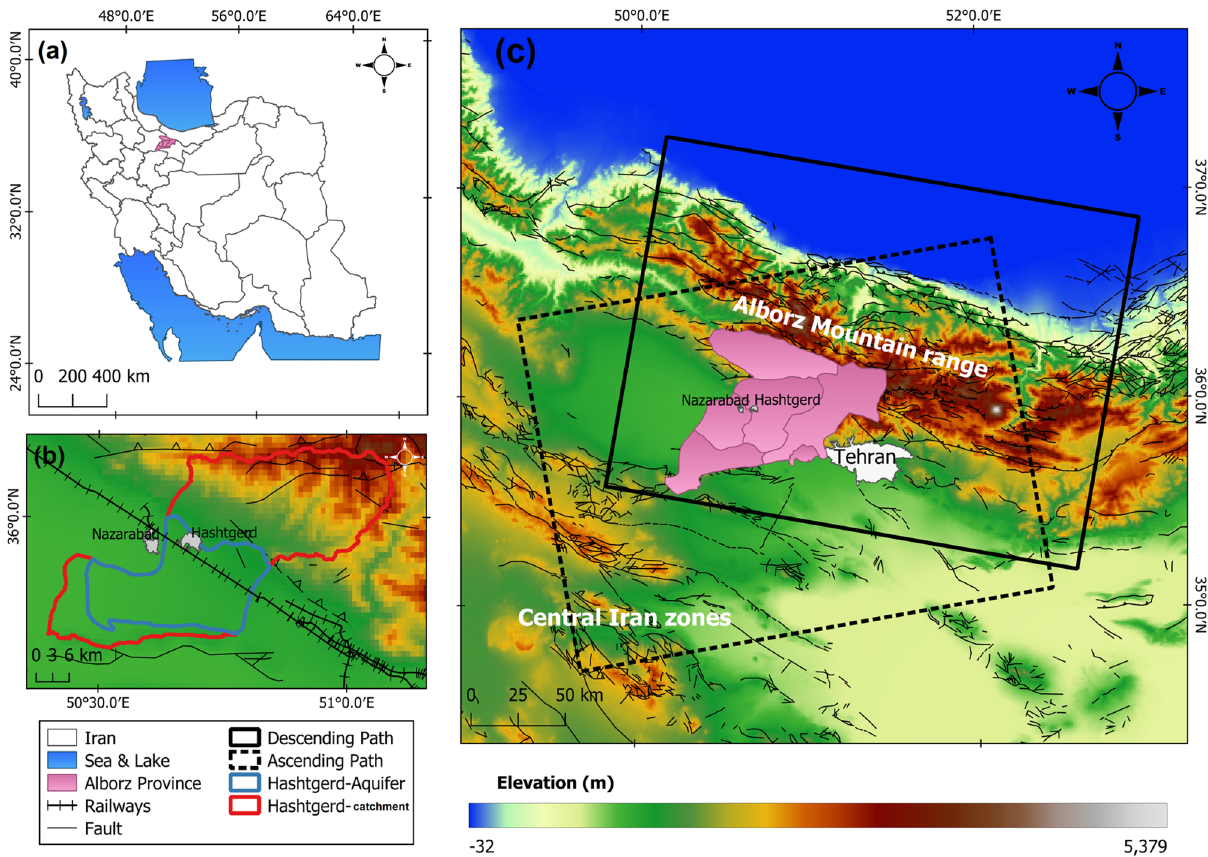
Figure 1. Study area, ( a ) location of Alborz province in Iran, ( b ) position of the Sentinel-1 images’ ascending and descending tracks on digital elevation model (DEM) of the region, ( c ) Hashtgerd catchment and aquifer and faults of the region under study. This figure was created using the QGIS version Desktop 3.18.1 software (https:// qgis. org/ en/